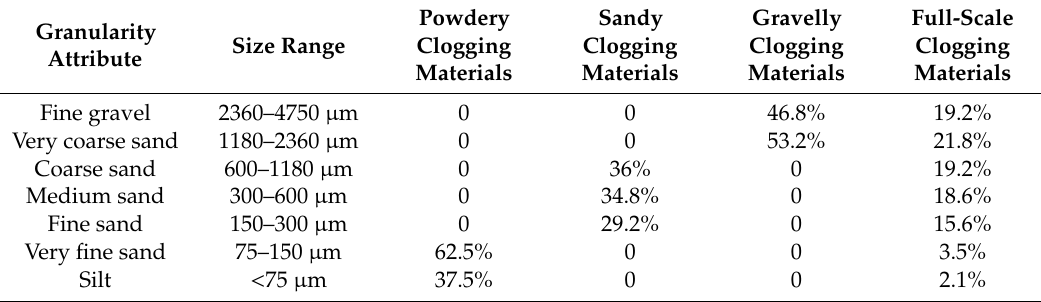
Table 12. The gradation of powdery clogging materials, sandy clogging materials, gravelly clogging materials and full-scale clogging